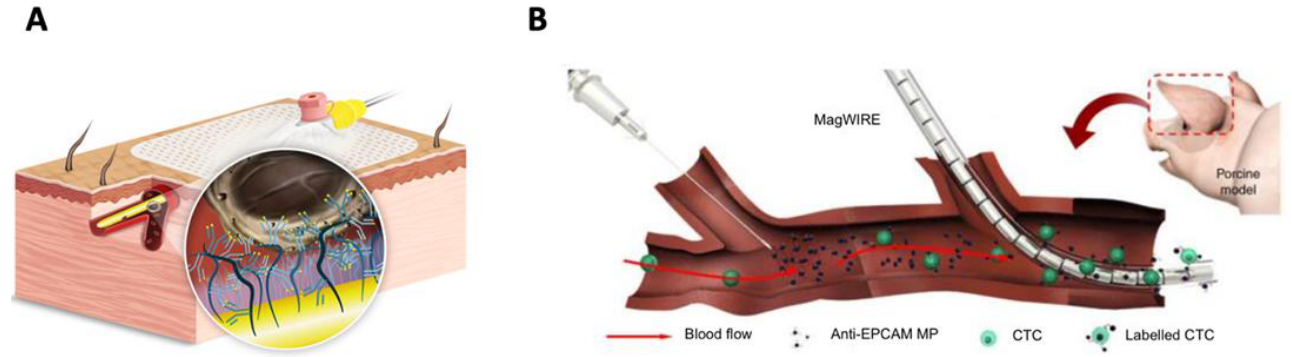
Figure 18 . In vivo solutions for CTC isolation. ( A ) Blood screening with the CellCollector TM for in vivo CTC capture (https://gilupi.com, accessed on 10 December 2021) ( B ) Capture of CTCs with the MagWIRE producing high magnetic gradients for efficient cell recovery. Reprinted from [231] with permission form Springer Nature.